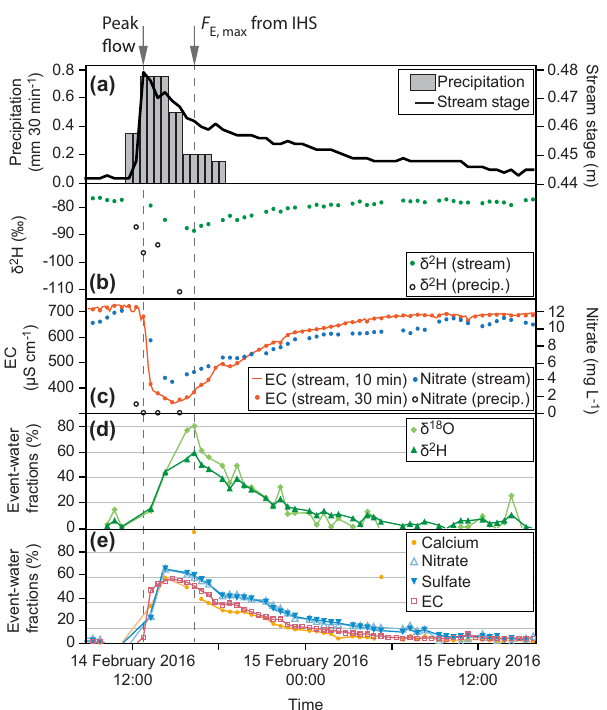
Figure 7. Precipitation Event 1 together with the (a) hydrologic, (b) isotopic, and (c) chemical responses in stream water. Pan- els (d) and (e) show the fractions of event water based on isotopic and chemical hydrograph separation, respectively, which are simi- lar for both types of tracers. However, the timing of the maximum event-water fraction ( F E , max ) differs, with the isotopes indicating the largest contribution of event water around 3h after the peak flow was reached. In panel (e) , the gaps in the F E time series based on calcium concentrations are due to measurement outliers.